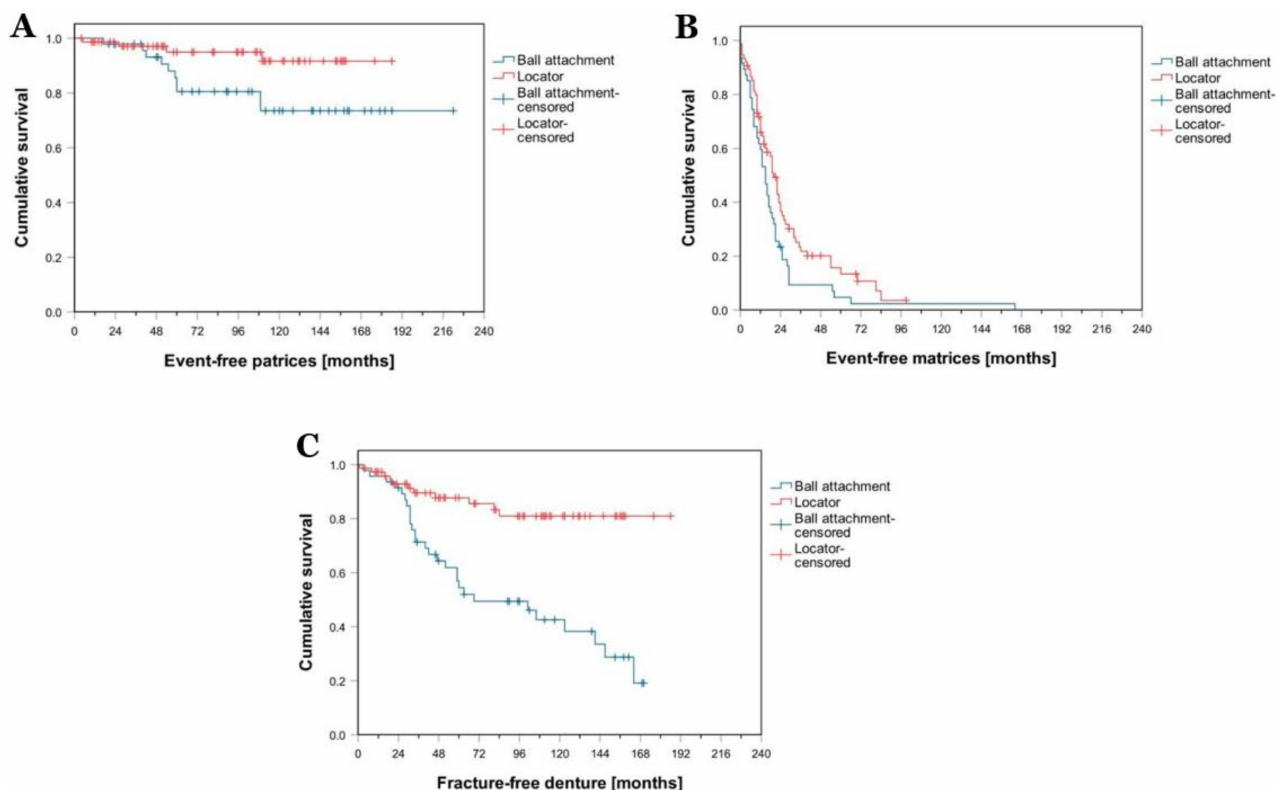
Figure 4. Results of Kaplan–Meier survival curves regarding patrix-related events ( A ), matrix-related events ( B ), and denture fracture ( C ) for locator and ball attachments